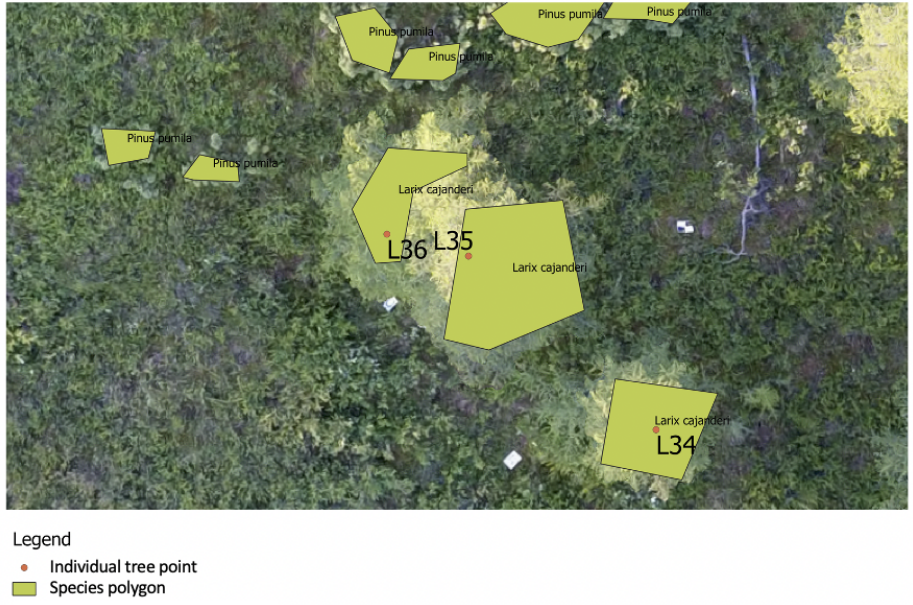
Figure 6. Examples of the individual point labels and examples of species polygons. Where possible, the species polygon overlaps the individuals labeled in the field, e.g., the larch at L34, L35, and L36. Additionally, the Pinus pumila were not recorded in the field but are added in the species shapefile. Both shapefiles are visualized on the red–green–blue (RGB) orthoimage of plot